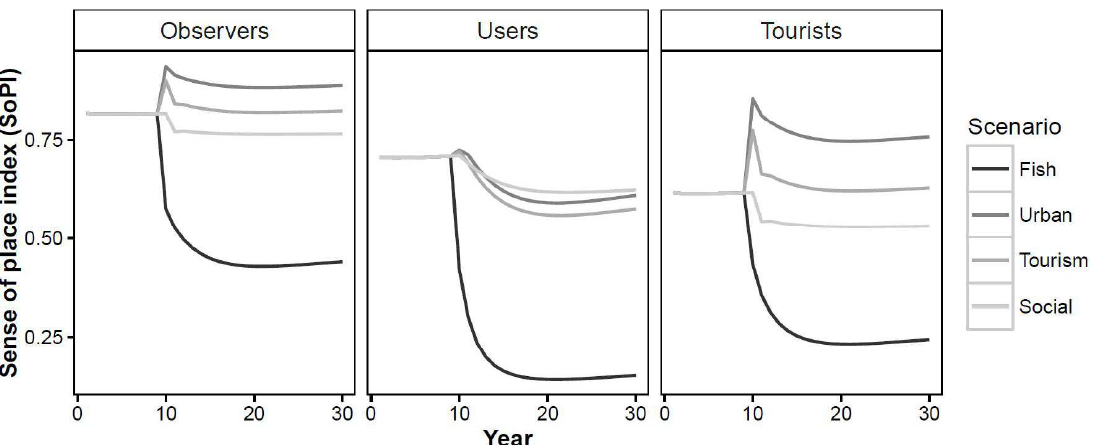
Figure A1.3: Modelled sense of place index for observers, users and tourists of a hypothetical marine socio-ecological system with feedback between land quality (L), marine quality (W), and fish abundance (F), for four perturbation scenarios.